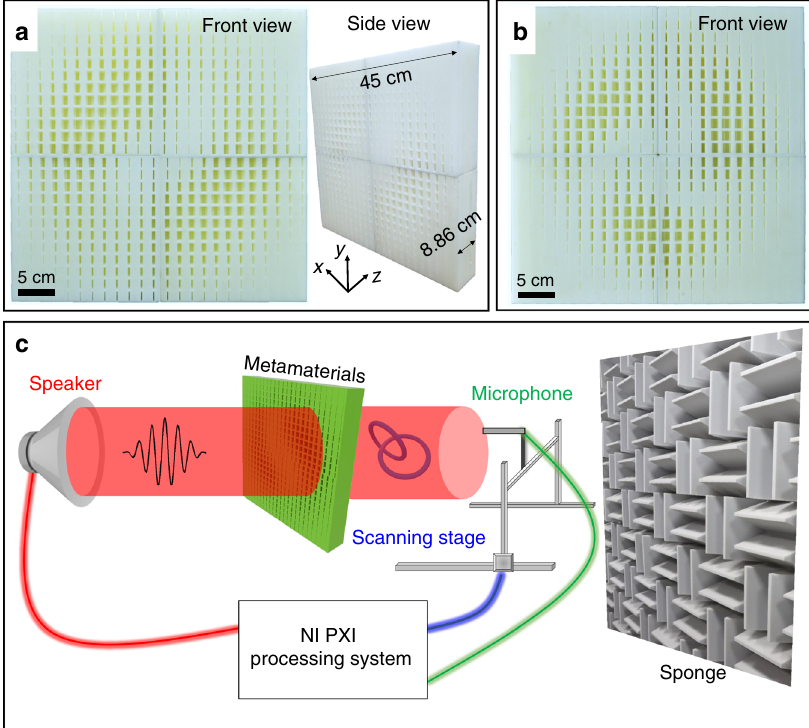
Fig. 2 The fabricated sample and experimental set-up. a , b show the photograph of the fabricated metamaterials sustaining Hopf link and trefoil knot vortex loops, respectively. Both samples are about 45 × 45 cm 2 in the transverse plane and the thickness is about 8.86 cm. c The schematic diagram of the experimental